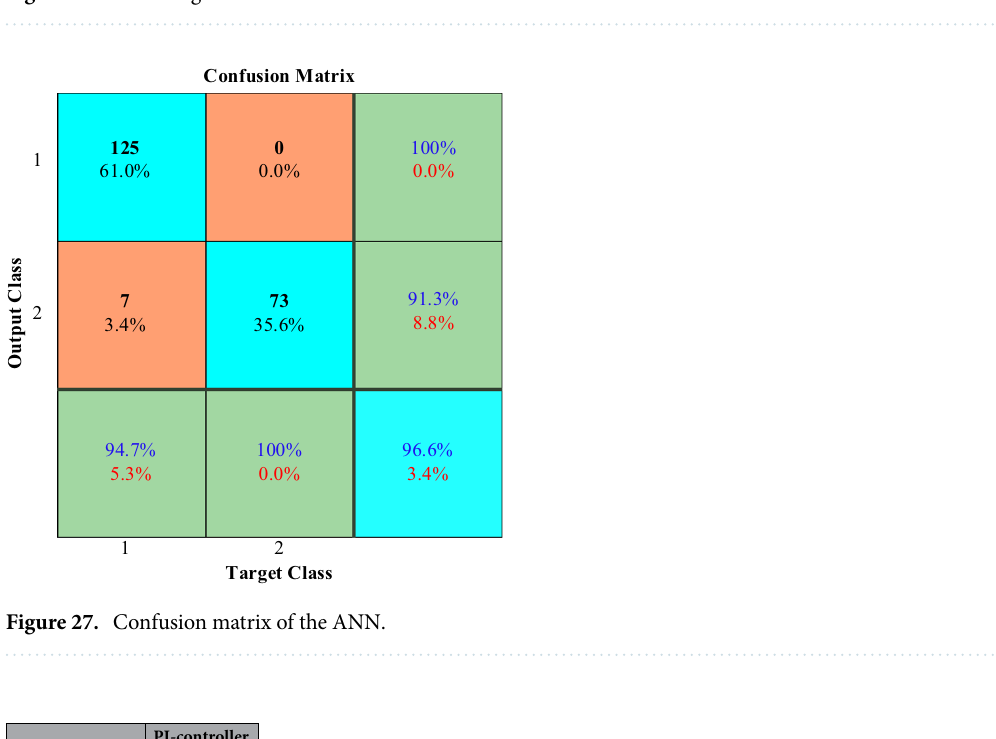
Figure 26. ROC diagram of the ANN.